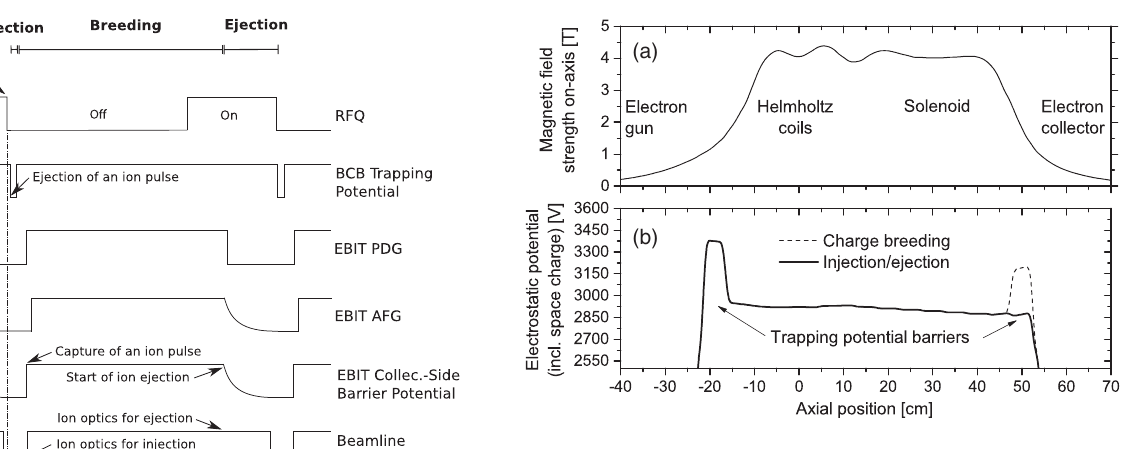
FIG. 5. (a) Magnetic field distribution measured on-axis of the ReA EBIT ’ s magnet composed of a pair of coils in the (quasi-) Helmholtz configuration and a long solenoid, and (b) injection, space-charge potential on axis of a 300-mA electron